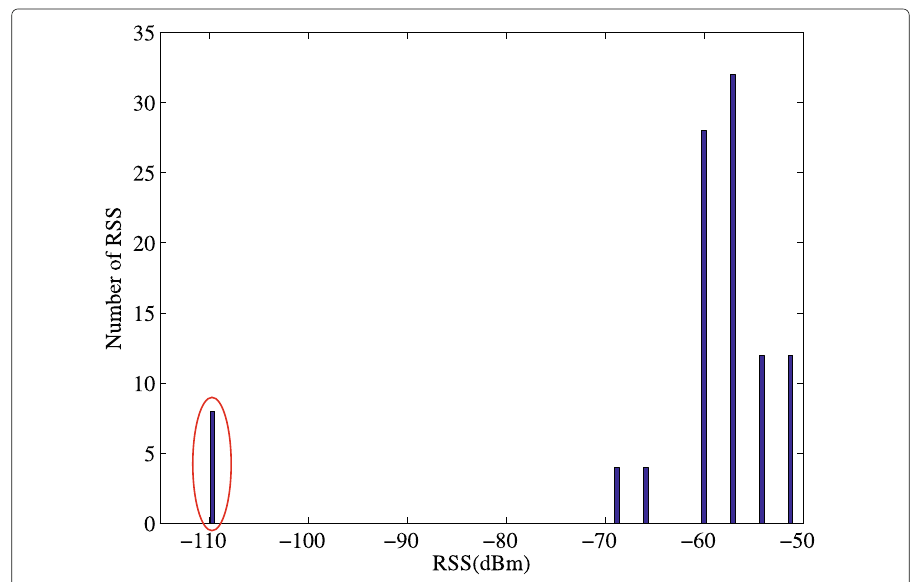
Fig. 3 RSS values collected in the same place at different time